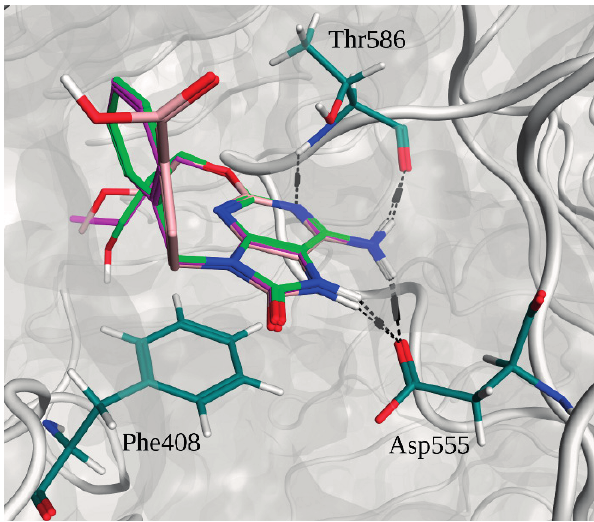
Figure 5. Superimposition of the binding poses of adenine derivative agonists and main interactions with TLR7.The 52455 carbons are depicted in purple. The 52542 carbons are depicted in light green. The 1V209 carbons are depicted in pink. Residue carbons are depicted in dark green. Nitrogens are depicted in blue. Polar hydrogens are depicted in white. Oxygens are depicted in red. Pocket surface is represented in gray. Hydrogen bonds are represented in